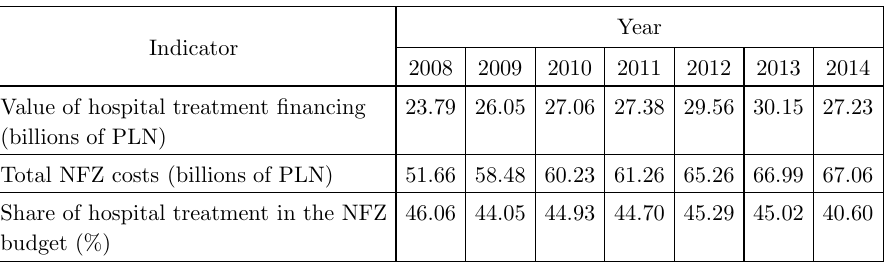
Table 1. The share of hospital financing in the Polish public payers’ budget – the National Health Fund